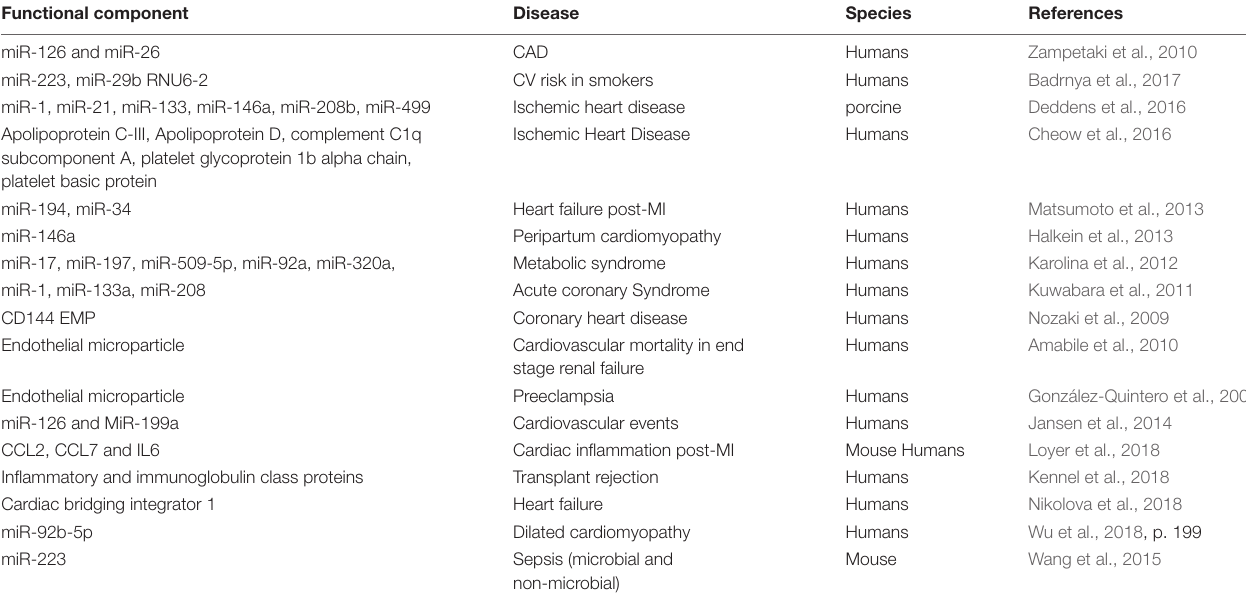
TABLE 2 | Studies demonstrating exosomes diagnosis and treatment of heart